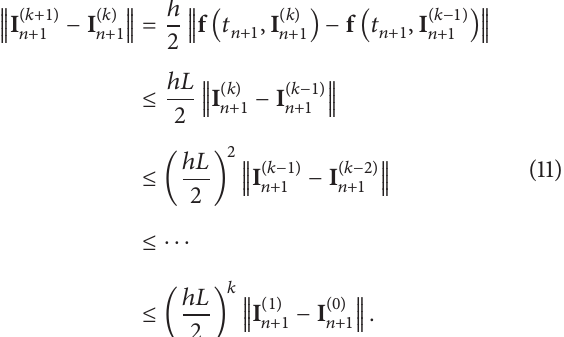
− 𝑡 𝑛+1 𝑛 , representing the step value in the